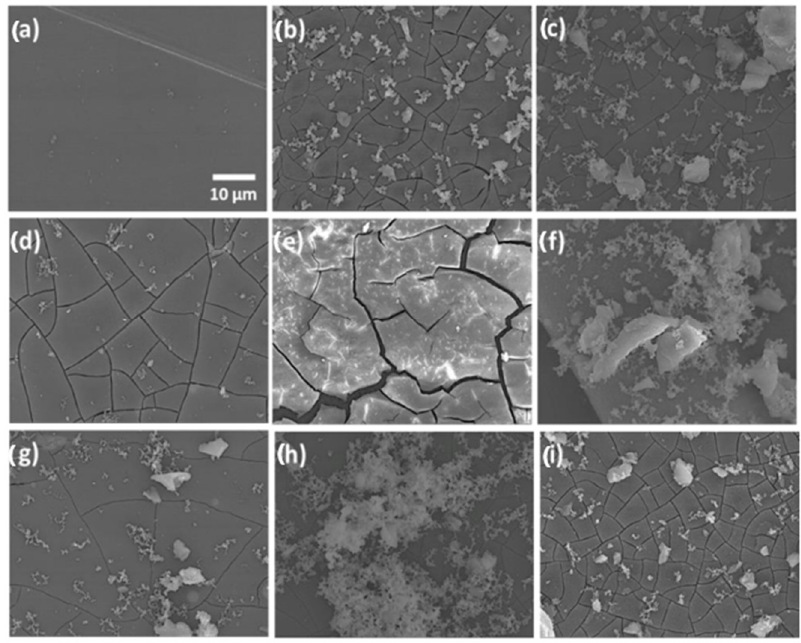
Figure 3. SEM scans of the substrates: ( a ) specimen 0, untreated AZ61 alloy; ( b ) specimen A, deteriorated AZ61 alloy following the HBSS investigation; ( c ) deteriorated specimen A-SG; ( d ) deteriorated specimen A-SG-CIS; ( e ) deteriorated specimen A-SG-DMG; ( f ) deteriorated specimen A-SG-QUI; ( g ) deteriorated specimen A-SG-AMIN; ( h ) deteriorated specimen A-SG-GRA; and ( i ) deteriorated specimen A-SG-TI. Reprinted with permission from Ref. [36]. MDPI (2022).